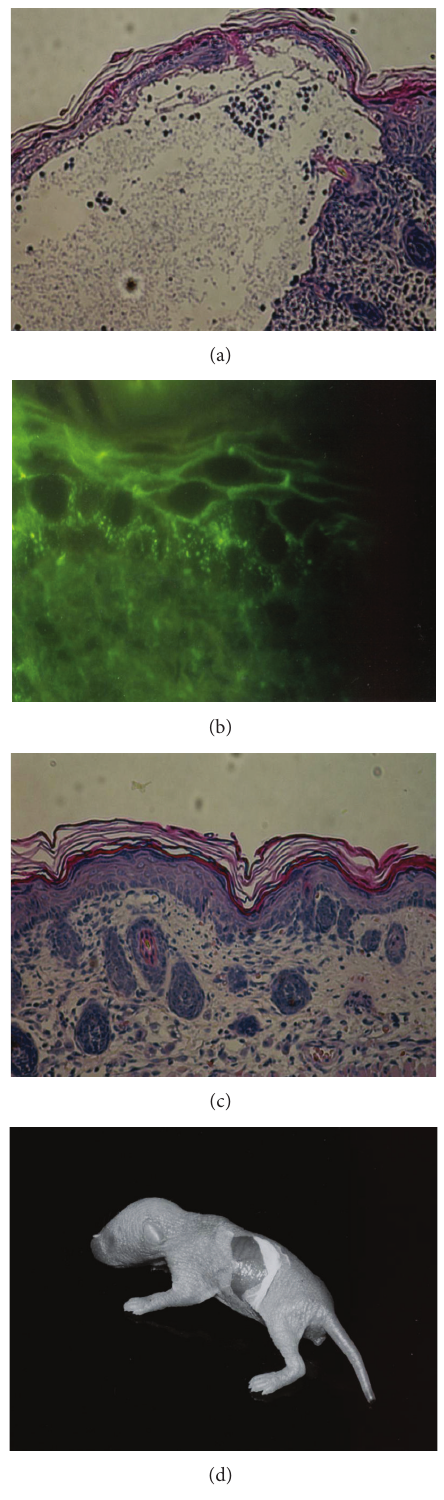
Figure 1:(a) Histology ofa PVlesionfrom awild-type miceinjected with PV IgG. (b) Direct immunofluorescence in wild-type mice injected with PV IgG showing IgG bounded to the intercellular cell surface (100x). (c) Histology of mice treated with IgG deprived plasma, no acantholysis is observed. Immunofluorescence studies were also negative (data not shown). (d) A large erosion on the back of a mice treated with PV